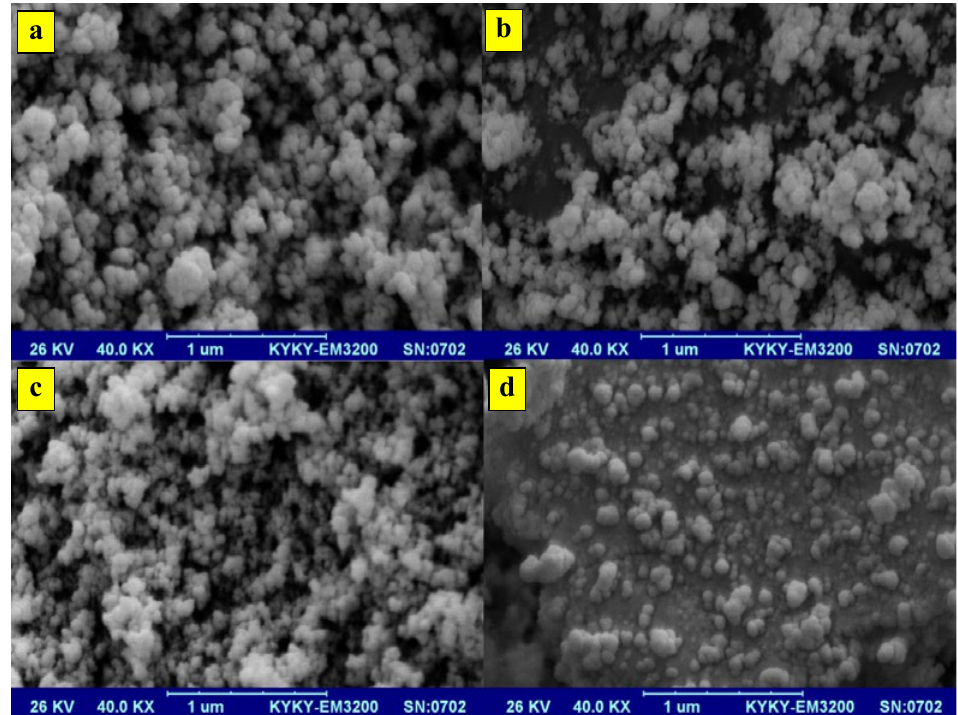
Fig. 1: SEM images of samples synthesized at 70 o C at different hydrothermal aging times. (a) 30 h, (b) 48h,(c) 72 h, (d) 96 h.